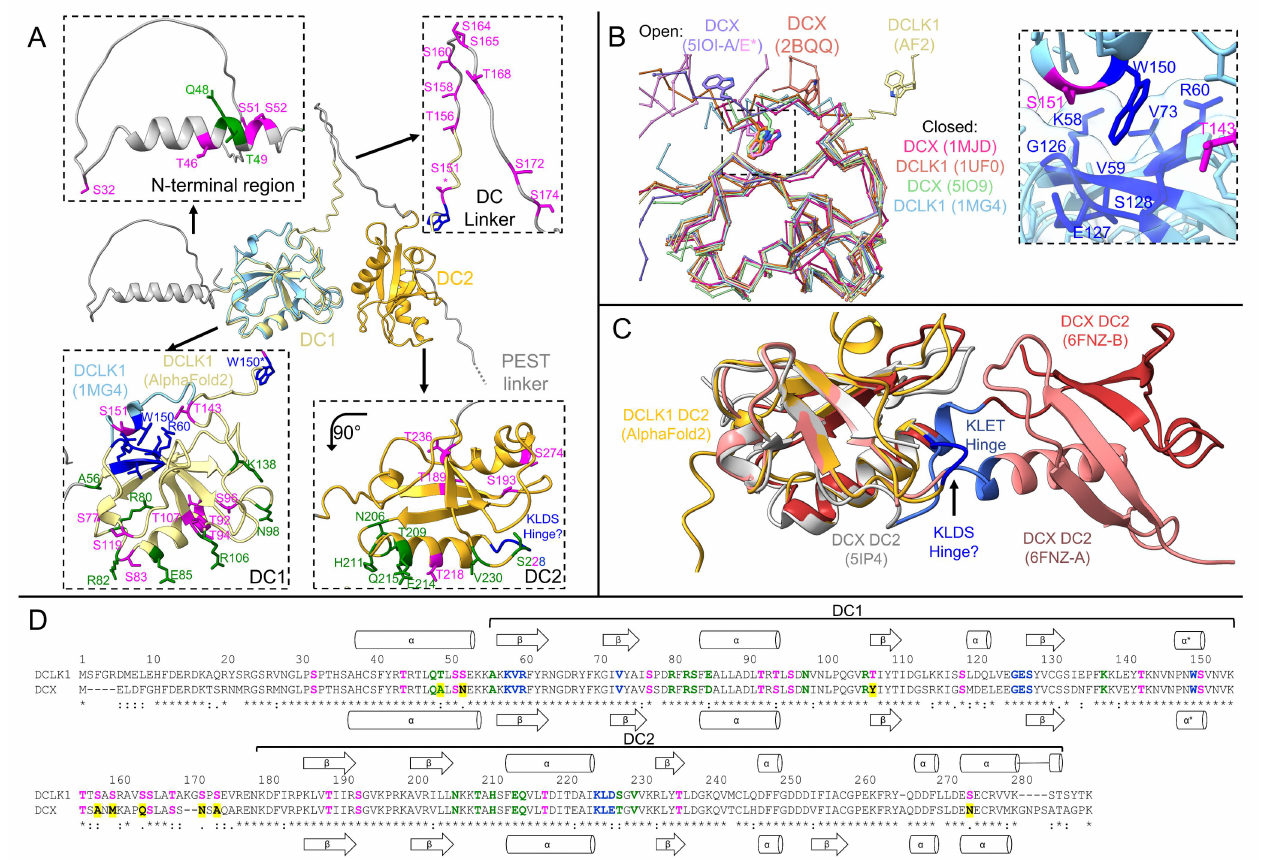
Figure 3. Mapping of residue function on the DC domains of DCLK1: ( A ) cartoon representa- tions of the AlphaFold2 prediction of DCLK1 (Isoform 2, yellow/gray) and the crystal structure of DCLK1-DC1 (PDB ID: 1MG4, light blue). Zoom panels highlight functional residues in each domain: αβ -tubulin binding (green), conformational switch (blue), and auto-phosphorylation (magenta); ( B ) comparison of open and closed structures of DC1 from DCLK1 and DCX, showing only the C-alpha backbone for clarity. PDB IDs are provided in parentheses. The zoom panel shows the tryptophan (W)150 pocket in DCLK1 (PDB ID: 1MG4) with surrounding residues (blue) highlighting nearby phosphorylation sites (magenta); ( C ) comparison of monomeric structures of DC2 with the domain swapped dimer structure (salmon/red). The KLET hinge in DCX which flips out to mediate the domain swap, and the equivalent residues in DCLK1 (KLDS), are highlighted in blue; and ( D ) se- quence alignment of DCLK1 and DCX colored according to assigned function as in ( A ). Differences in functional residues are highlighted in yellow. Experimentally determined and predicted secondary structures are depicted. Residue numbers for DCLK1 are shown above with the boundaries of the DC domains indicated. Sequence alignment performed using PROMALS3D [84] and structures rendered in UCSF ChimeraX v1.5